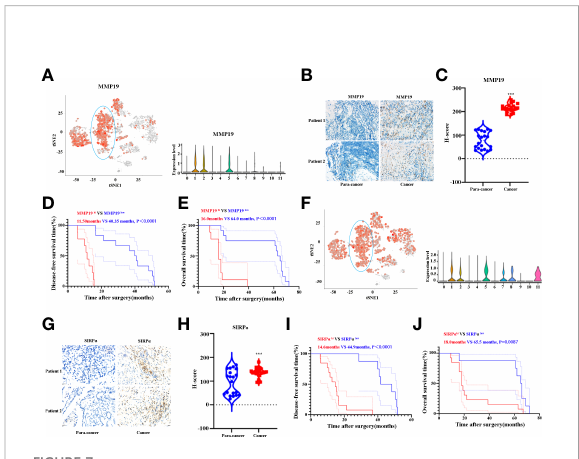
FIGURE 7 (A) tSNE plots, and Violin plots for the expression of MMP19